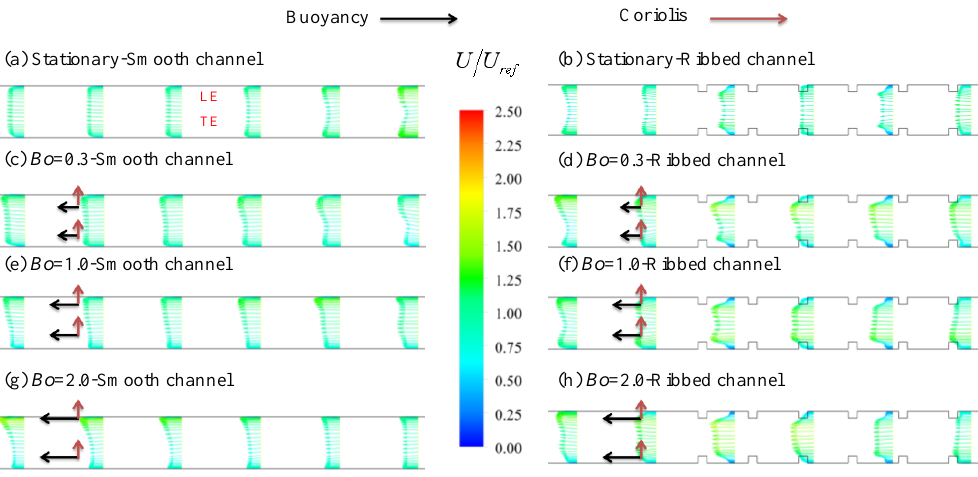
Figure 9. 2D velocity vectors in the central section of the second passage ( X / W = 2.0).